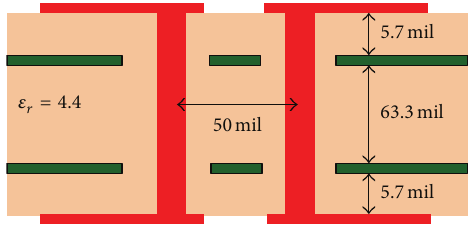
Figure 13: Side view of differential vias structurein single plane